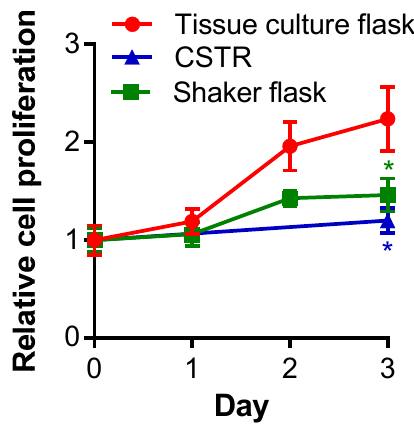
Figure 2. The relative number of cells measured over three days in the different bioreactors, including tissue culture flasks, CSTR, and shaker flasks. Data are presented as means ± standard deviation ( n = 3). * indicates significant differences ( p < 0.05) compared to tissue culture flasks at day 3 analyzed by one-way ANOVA.